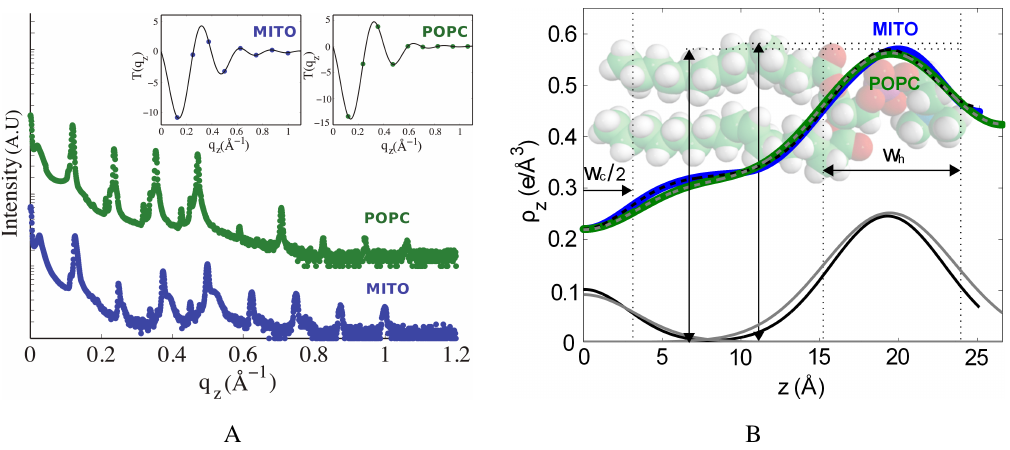
Electron density profiles of the mitochondria-like and POPC membranes. ( A ) The reflectivity curves for the mitochondria-like and POPC membranes (the latter was shifted upwards for clarity) show eight and nine well-developed Bragg peaks, respectively. The insets show the fits of the peaks amplitude with the continuous T ( q z ) function, plotted for the best combination of phases, ν n . ( B ) The electron density profiles of the mitochondria-like and POPC membranes were determined from the data shown in (A) and modelled with Gaussian peak profiles to represent different lipid molecular components, as explained in the text. The Gaussian components of the fit corresponding to the headgroup region and the chain terminal CH 3 region are represented in black and grey for the mitochondria-like and POPC membranes, respectively. Dashed lines represent the result of the fit. The FWHMs of the headgroup region, w h , and chain terminal region, w c , are indicated on the figure, and their values are listed in Table